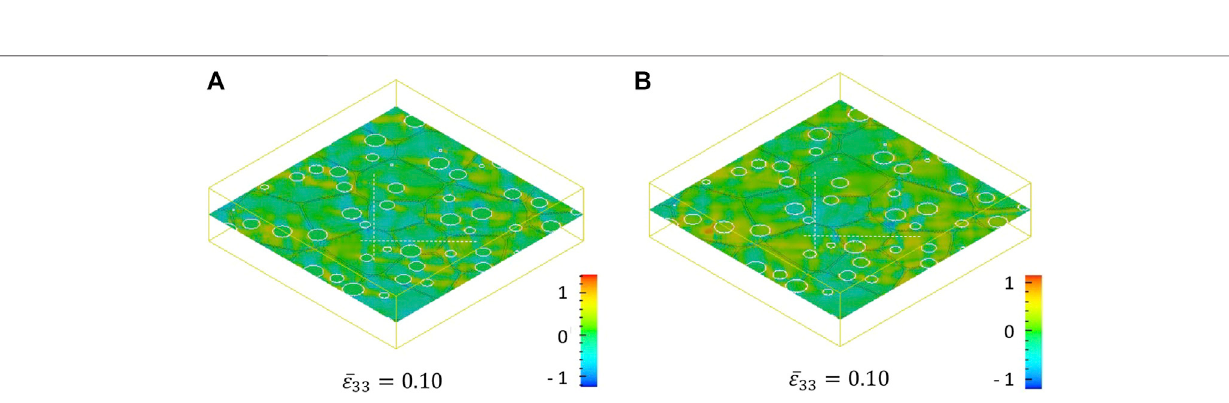
(cid:2) 1 . 2GPa. gb